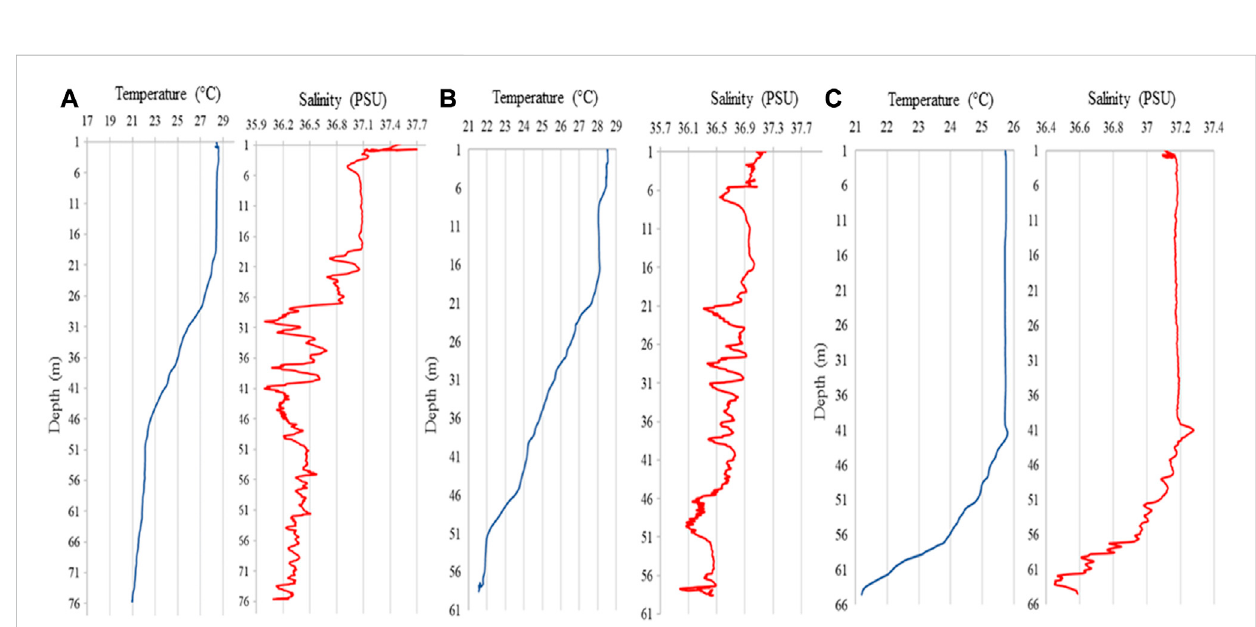
FIGURE 11 Temperature( ° C)andSalinity(PSU)pro fi les: (A) Valleybottomduringsummer; (B) Adjacentareaduringsummer; (C) Adjacentareaduringfall/winter.